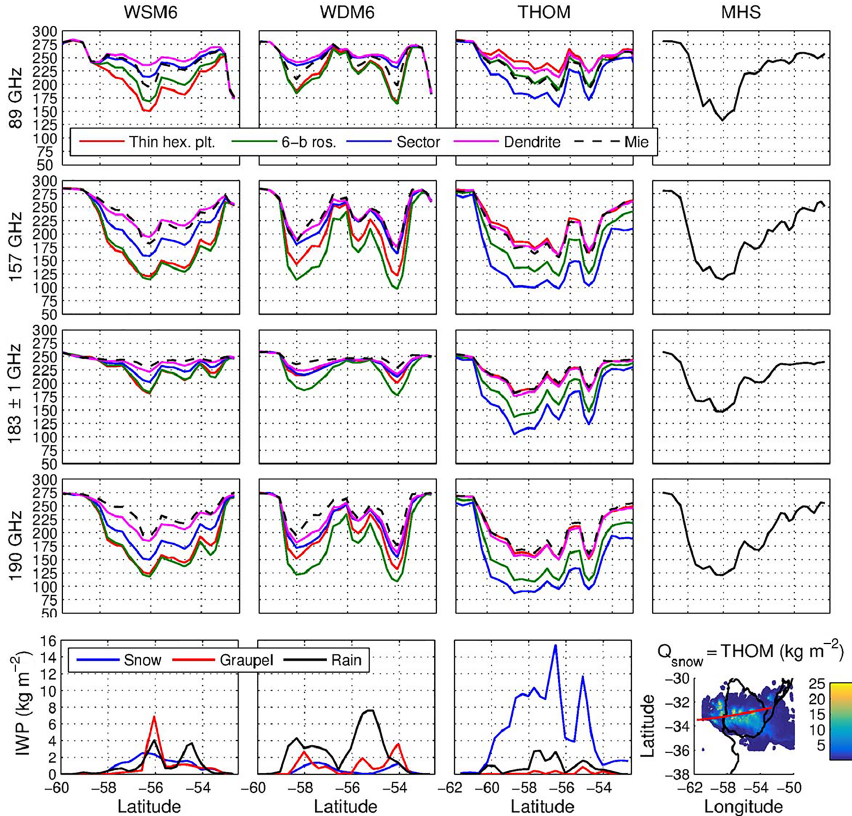
Figure 9. Similarly to Fig. 7, the simulated brightness temperatures for the 89, 157, 183 ± 1 and 190GHz MHS channels along the transect of interest shown in Fig. 4i using a selection of Liu (2008) DDA habits and the soft-sphere Mie approach and the WSM6, WDM6 and THOM WRF schemes (in the first three columns). The last column shows reference MHS observations for the transect in solid black lines. The corresponding integrated mass content of snow, graupel and rain are shown in the bottom row. Note that the bottom right panel shows the column-integrated WRF(THOM) snow mass content for the whole scene together with a solid red line to illustrate the location of the transect of